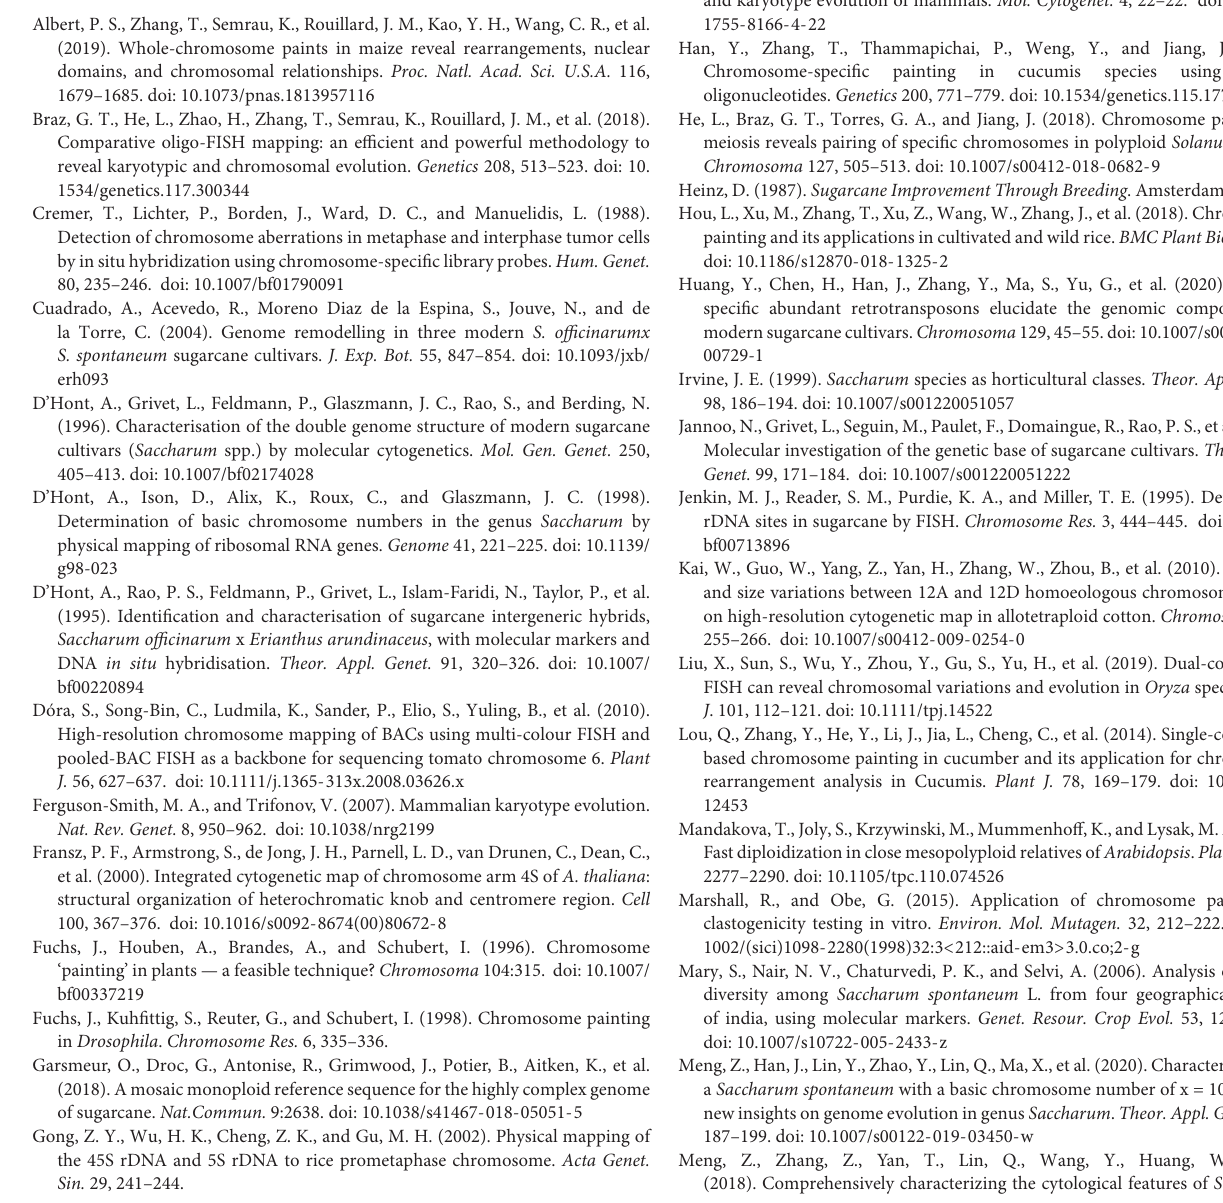
Supplementary Figure 1 | FISH mapping with the CP2 probe in S. spontaneum clones. FISH assays using the CP2 probe in 11 S. spontaneum clones, Yunnan82-16 (A) , Yunnan82-67 (B) , Yunnan82-110 (C) , Yunnan76-III-13 (D) , Yunnan76-III-18 (E) , Sichuan92-42 (F) , Sichuan79-II-20 (G) , Sichuan79-II-18 (H) , Sichuan88-16 (I) , Sichuan79-II-11 (J) , and Fujian87-I-4 (K) . The ploidy is indicated on the corresponding clones. Scale bars, 10 µ m. Supplementary Figure 2 | FISH mapping using chromosome-specific probes in the three tridecaploid S. spontaneum clones. Three chromosome-specific probes, Ss5.1, Ss6.2, and Ss7, which are located on chromosomes 5, 6, and 7, respectively, were hybridized to the three S. spontaneum clones Fujian89-I-19 (A,B) , Fujian87-I-4 (C,D) , and Guizhou78-II-28 (E,F) . Thirteen copies of signals were observed from each probe. Scale bars, 10 µ m.